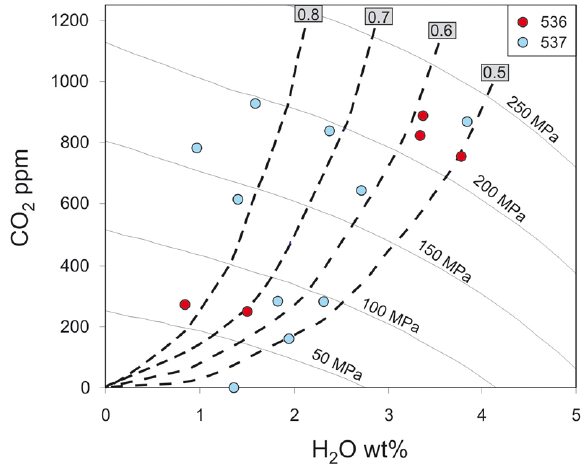
and H O dissolved in melt inclusions. 2 2